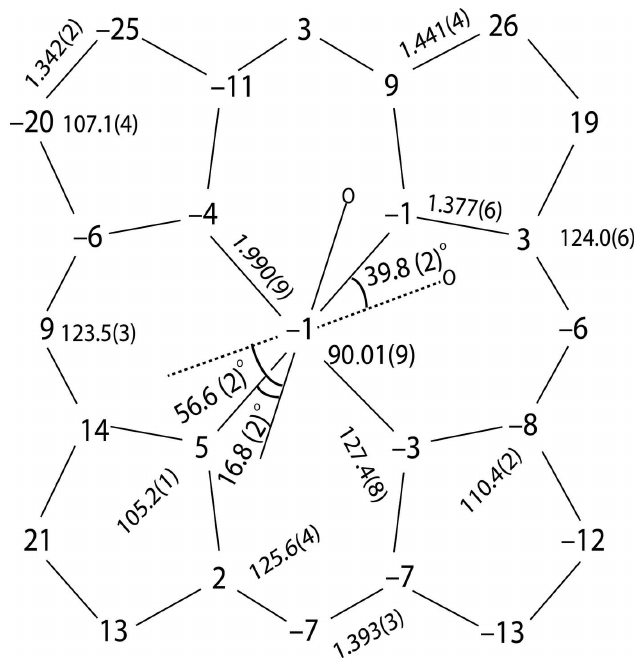
Figure 2 A formal diagram of the porphyrinato core of the title compound. Averaged values of the chemically unique bond distances (in A ˚ ) and angles ( (cid:3) ) are shown. The numbers in parentheses are the e.s.d.’s calculated on the assumption that the averaged values were all drawn from the same population. The perpendicular displacements (in units of 0.01 A˚ ) of the porphyrin core atoms from the 24-atom mean plane are also displayed. Positive values of the displacement are towards the hindered porphyrin side. The dashed line indicates the imidazole on the less hindered porphyrin side and the circles represent the positions of the methyl groups on the axial ligands.